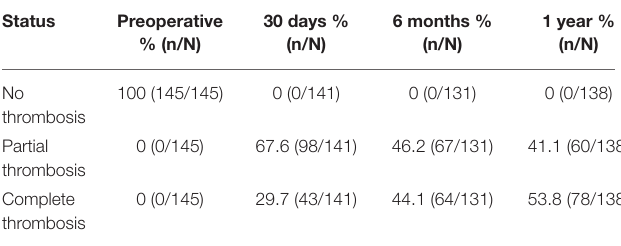
TABLE 6 | False lumen